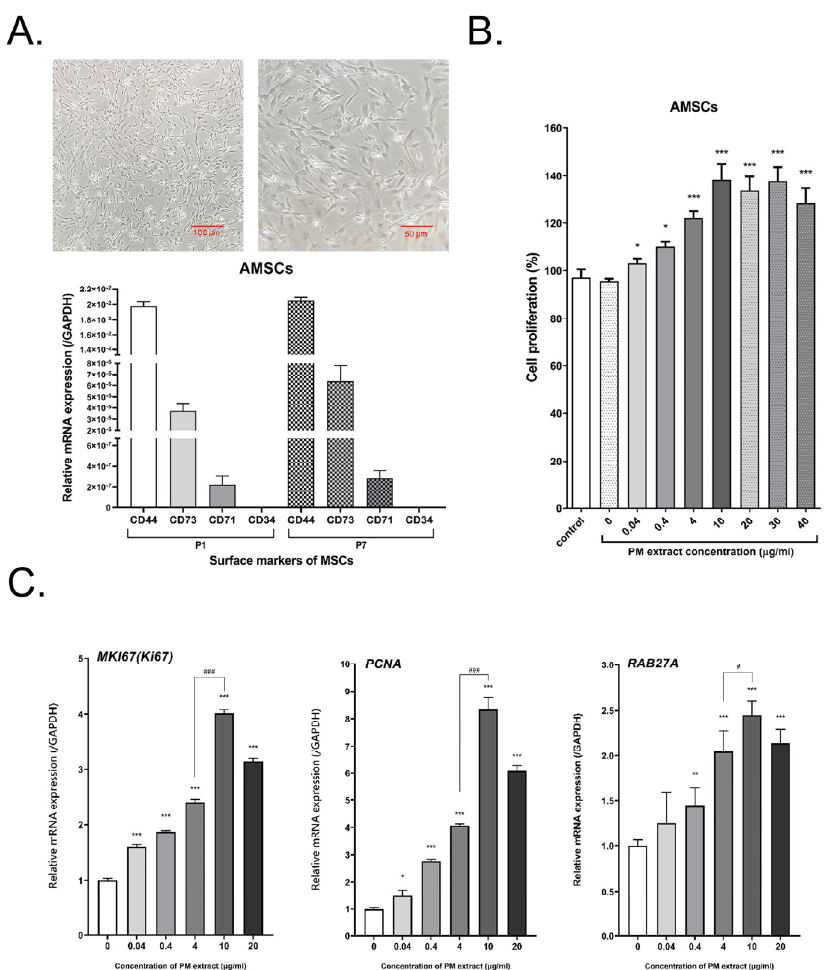
Figure 1. Avian − derived mesenchymal stem cell (ASMC) characteristics and effect of the Polygonum multiflorum (PM) extract on AMSCs. ( A ) The morphology and surface markers of AMSCs. (Bar = 100 μ m). ( B ) Treatment with the PM extract enhanced cell proliferation in AMSCs. (Number of repeats (n) = 4, data are expressed as the mean ± standard deviation; * p < 0.05, ** p < 0.01, *** p < 0.001, compared with the control group). ( C ) Treatment with the PM extract enhanced MKI67 , PCNA , and RAB27A expression in AMSCs. (n = 4, data are expressed as the mean ± standard deviation; ** p < 0.01, *** p < 0.001, compared with 0 μ g/mL; # p < 0.05, ### p < 0.001, compared with 4 μ g/mL).